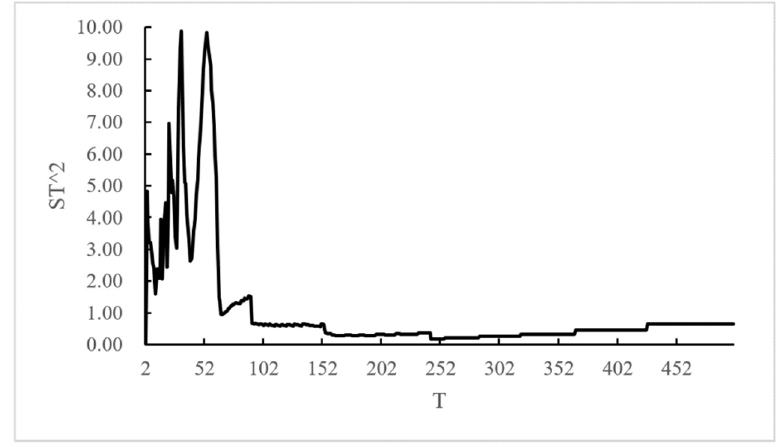
Figure 8. Incident time cycle.